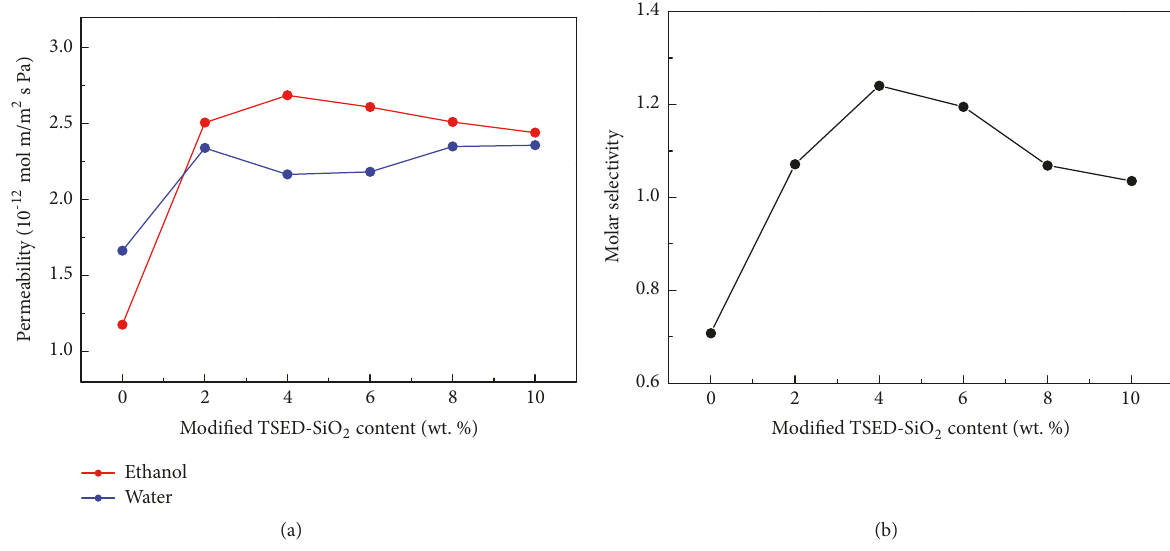
Figure 9: Effect of modified TSED-SiO 2 content on (a) ethanol permeability and water permeability and (b) molar